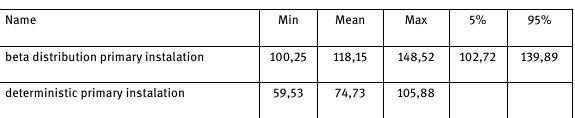
Table 3: The results of calculations for beta distribution and deter- ministic data for ceramic tile